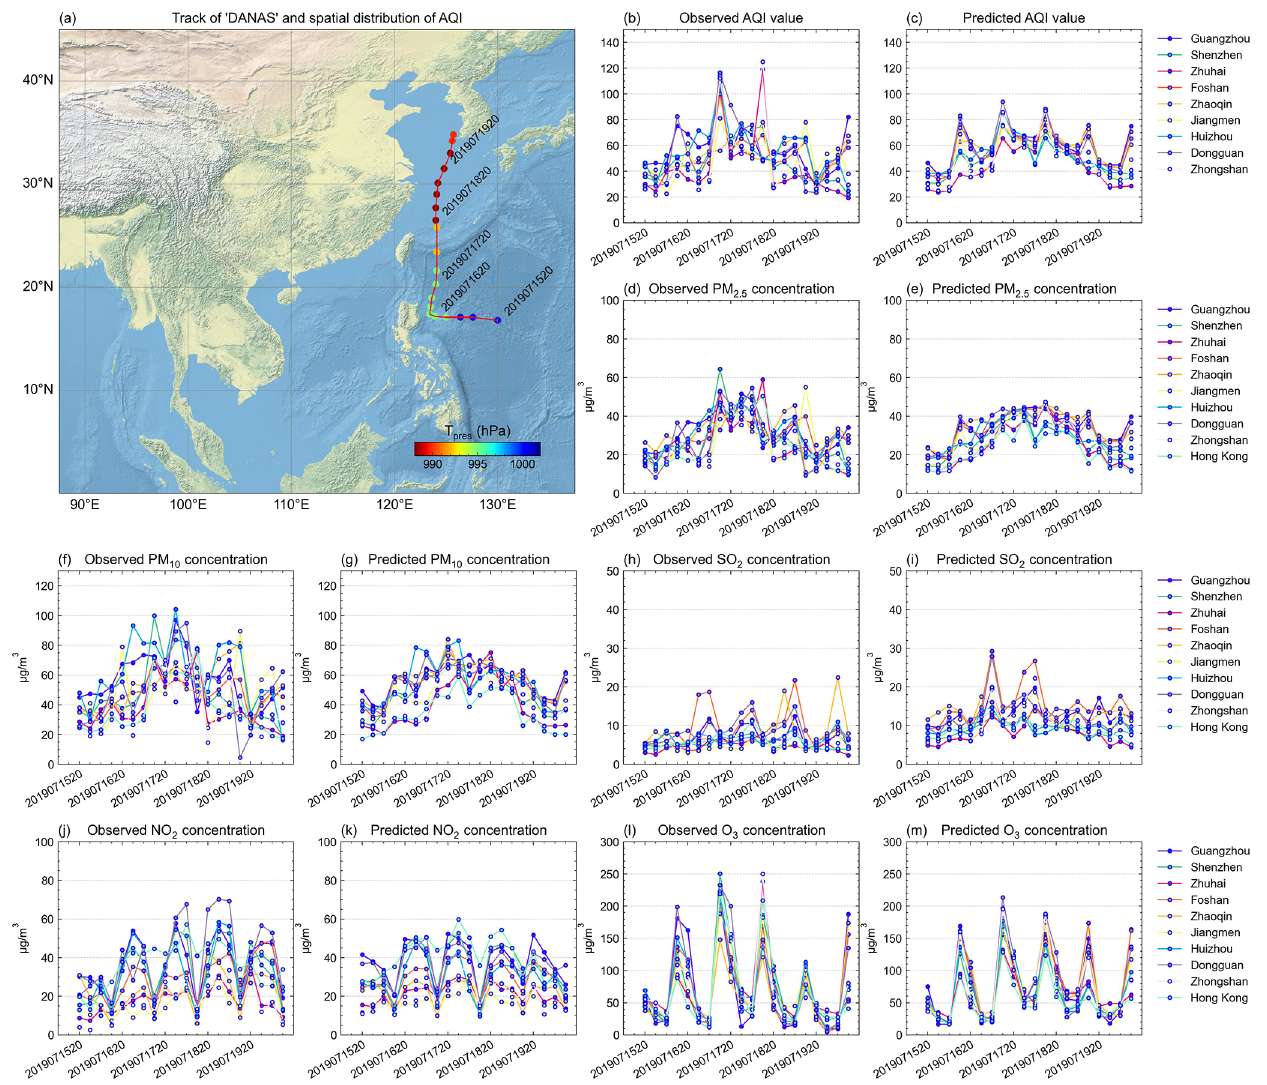
Figure 7. Track of Typhoon Danas (2019) and the observed and model-predicted air quality (the value of a city is the mean value of all its stations): (a) track and minimum pressure of Typhoon Danas from 20:00CST (China standard time) on 15 July 2019 to 14:00CST on 20 July 2019; (b) the observed AQI value; (c) the model-predicted AQI value; (d) the observed PM 2 . 5 concentration; (e) the model-predicted PM 2 . 5 concentration; (f) the observed PM 10 concentration; (g) the model-predicted PM 10 concentration; (h) the observed SO 2 concentration; (i) the model-predicted SO 2 concentration; (j) the observed NO 2 concentration; (k) the model-predicted NO 2 concentration; (l) the observed O 3 concentration; (m) the model-predicted O 3